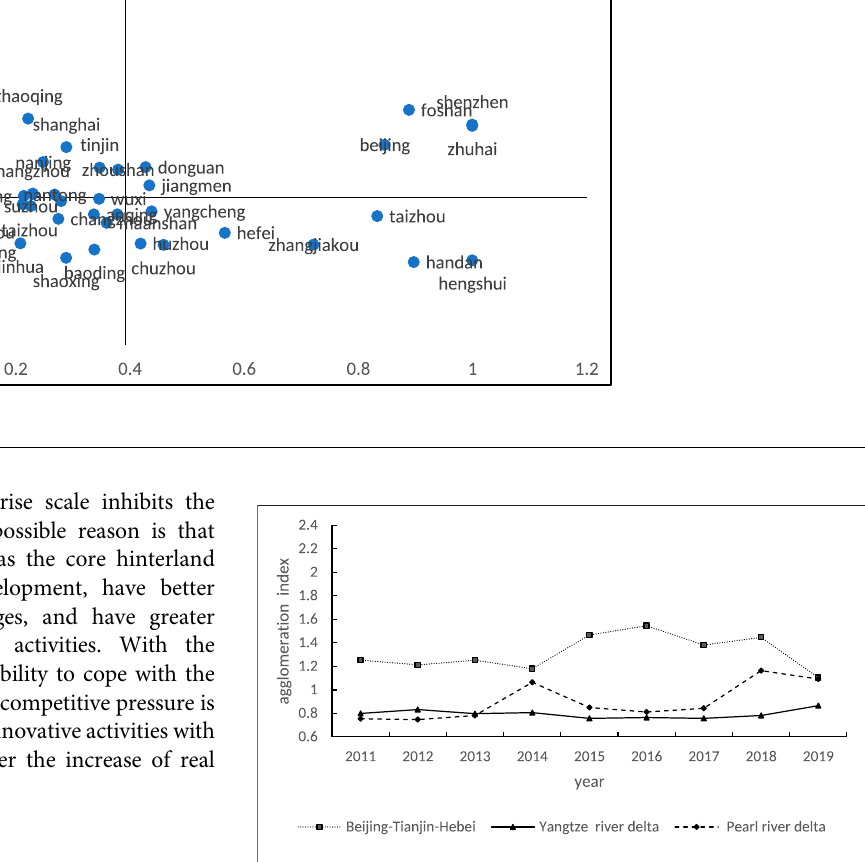
FIGURE 2 | Agglomeration of producer